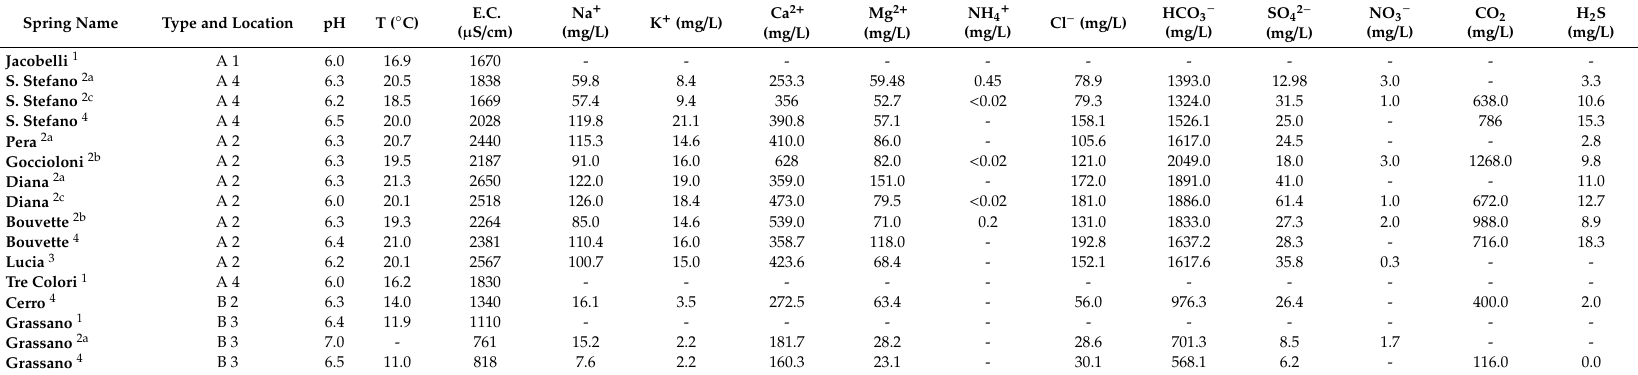
Table 3. Chemical and physical characteristics of spring and well waters. Type: A, sulfurous thermal spring; B, cold spring. Location: 1, Jacobelli Park; 2, Minieri Park; 3, Grassano Park; 4, other. S. Stefano, Pera, Goccioloni, and Bouvette are tapped by